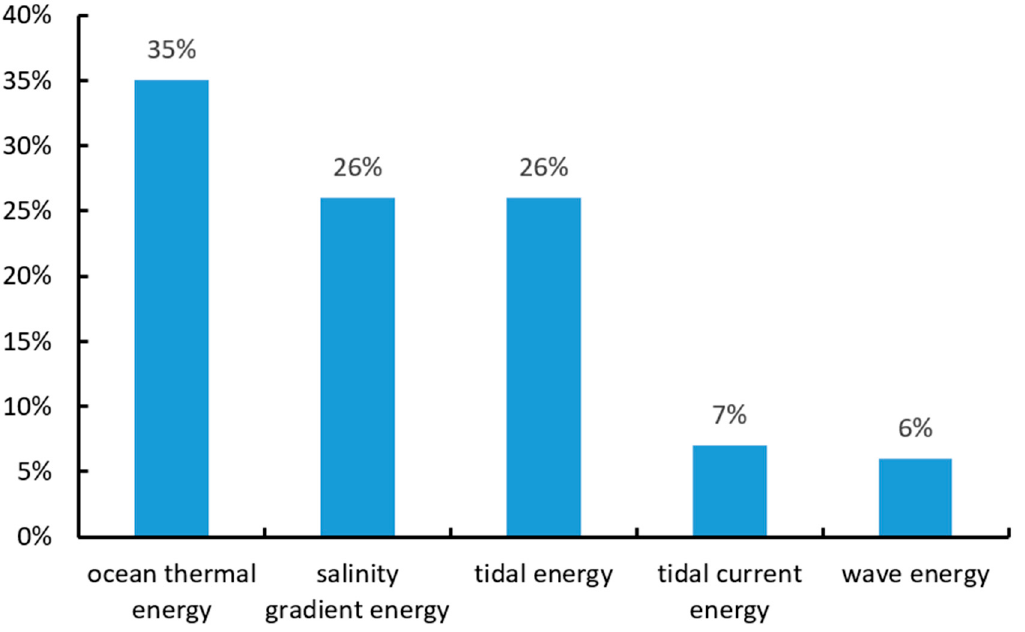
Figure 1. Renewable energy reserves in China.